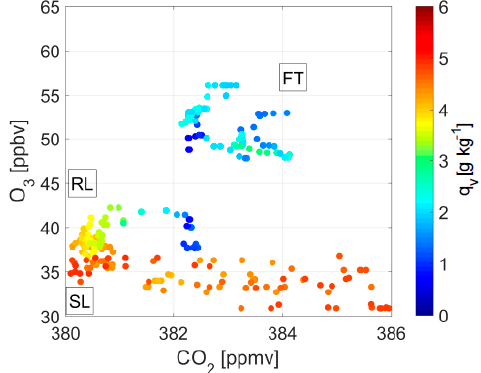
Figure 2. Scatter diagram of O 3 and CO 2 07:27UTC Figure 2. scatter diagram of O 3 and CO 2 07:27UTC [47].